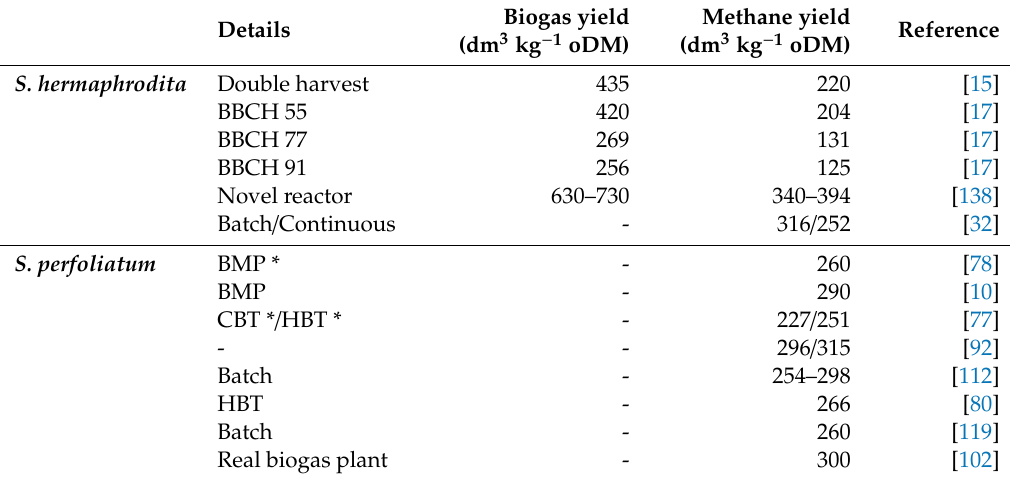
Table 8. Values of the biogas and methane yields from S. hermaphrodita and S. perfoliatum reported in the